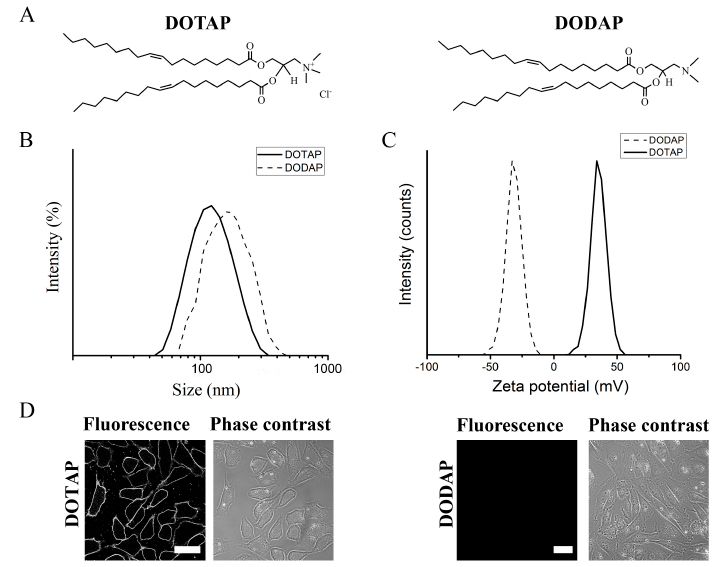
Figure 1. ( A ) Chemical structures of the positively charged lipid 1,2-dioleoyl-3-trimethylammonium-propane (DOTAP) and the neutral lipid 1,2-dioleoyl-3-dimethylammonium-propane (DODAP). ( B ) Hydrodynamic size and ( C ) zeta potential distributions of liposomes containing DOPE/DOTAP/BODIPY FL-DHPE and DOPE/DODAP/BODIPY FL-DHPE (1/1/0.1 mol/mol). ( D ) Fluorescence and phase contrast micrographs of CHO cells after treatment with liposomes containing DOTAP or DODAP. Scale bars, 20 µm.